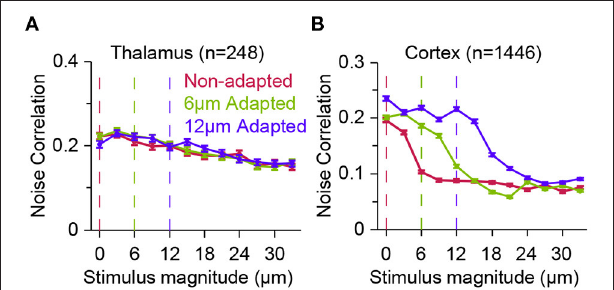
FIGURE 4 | Effect of adaptation on population response correlations along the thalamocortical pathway. (A) The correlations in trial-by-trial spike-count variability (known as noise correlation) for a population of thalamic neurons in three adaptation states, as in Figure 3 . Adaptation has small effect on the correlated variability across thalamic neurons. Error bars represent s.e.m. Colour conventions as in Figure 3 . (B) Similar to (A) but for cortical neurons. Adaptation produces a systematic shift in the noise correlation characteristic function. Modified from Adibi et al.